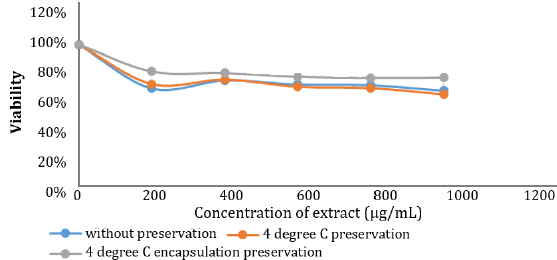
Figure 6. Viability of Vero cells after treated by kaffir